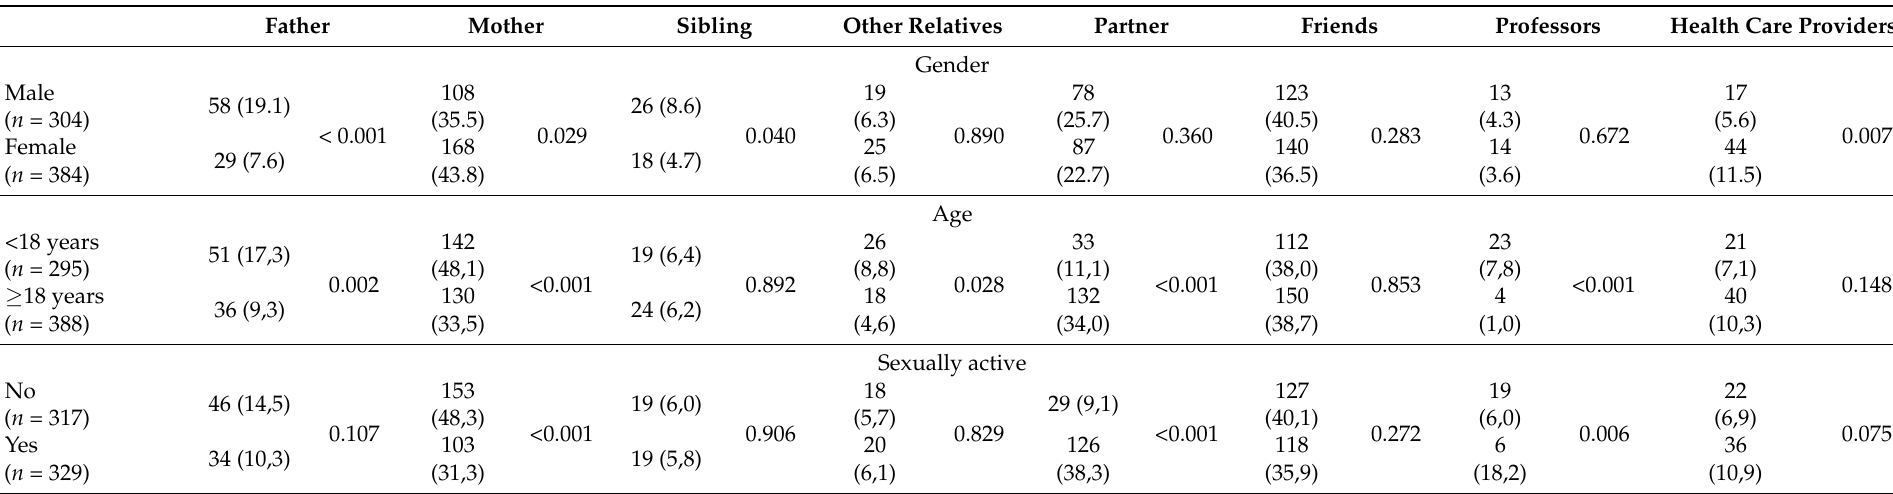
Table 4. People that participants feel more comfortable talking about